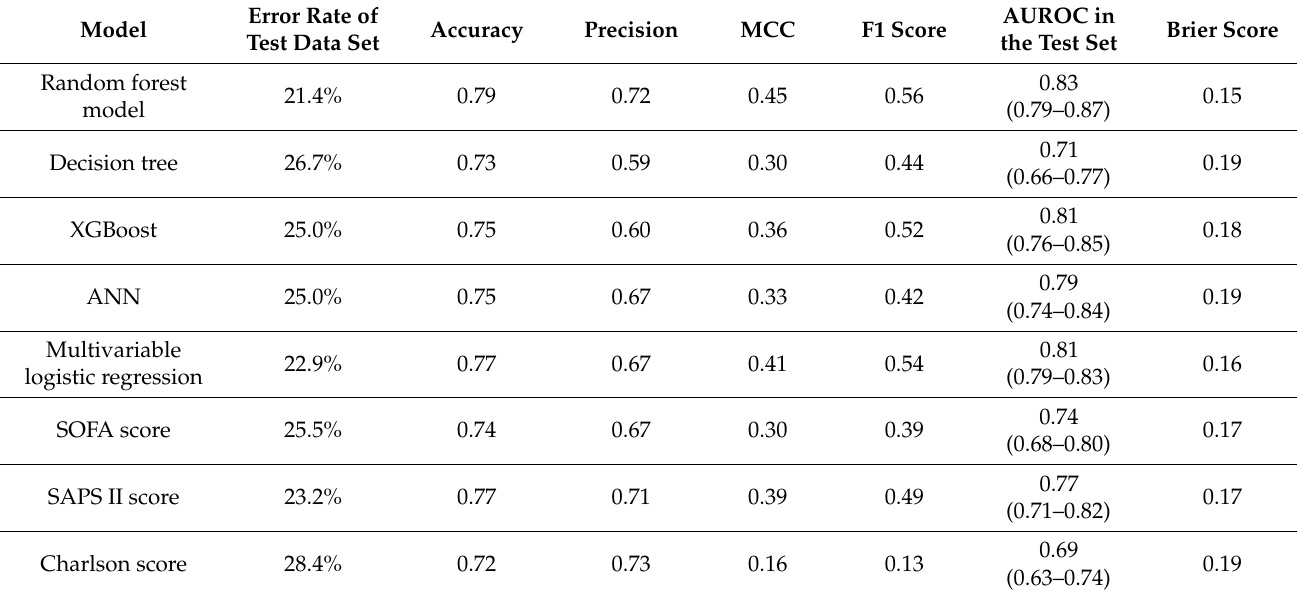
Table 2. Comparison of evaluation and calibration among the different models.